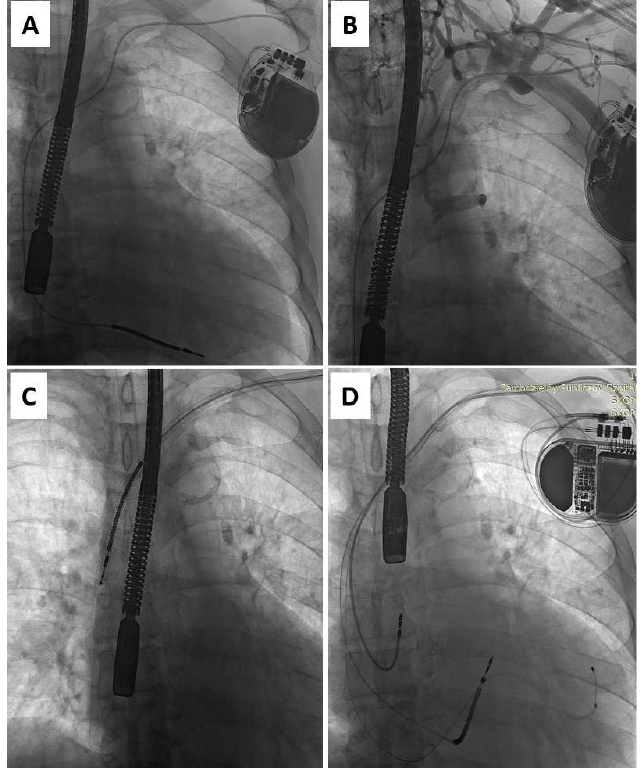
Figure 1. Upgrade from ICD ‐ V ( A ) to CRT ‐ D in the patient undergoing TLE for lead ‐ related venous obstruction ( B ). Moving the introducer sheath over the lead to the heart facilitates not only the re ‐ moval of the lead ( C ) but also reestablishing access for the implantation of three new leads ( D ).